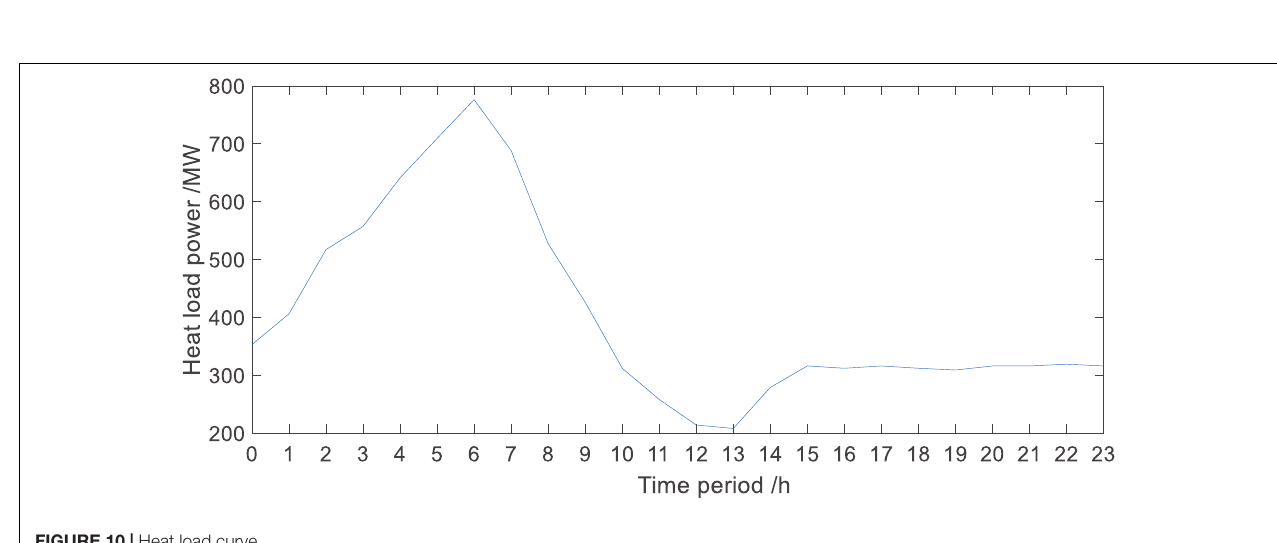
FIGURE 9 | Electric load and wind power output forecast curve.